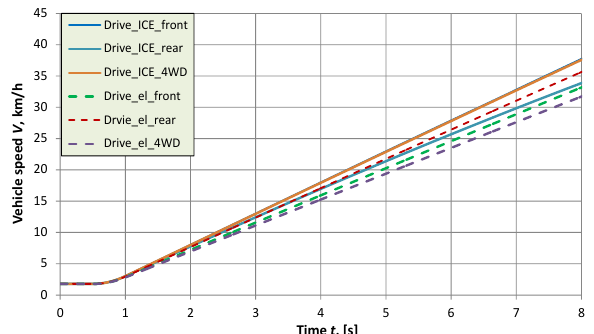
Fig. 7. Vehicle speed in speeding the vehicle straight ahead on a road with different adhesion coefficient under the wheels of the left and right side [own research]